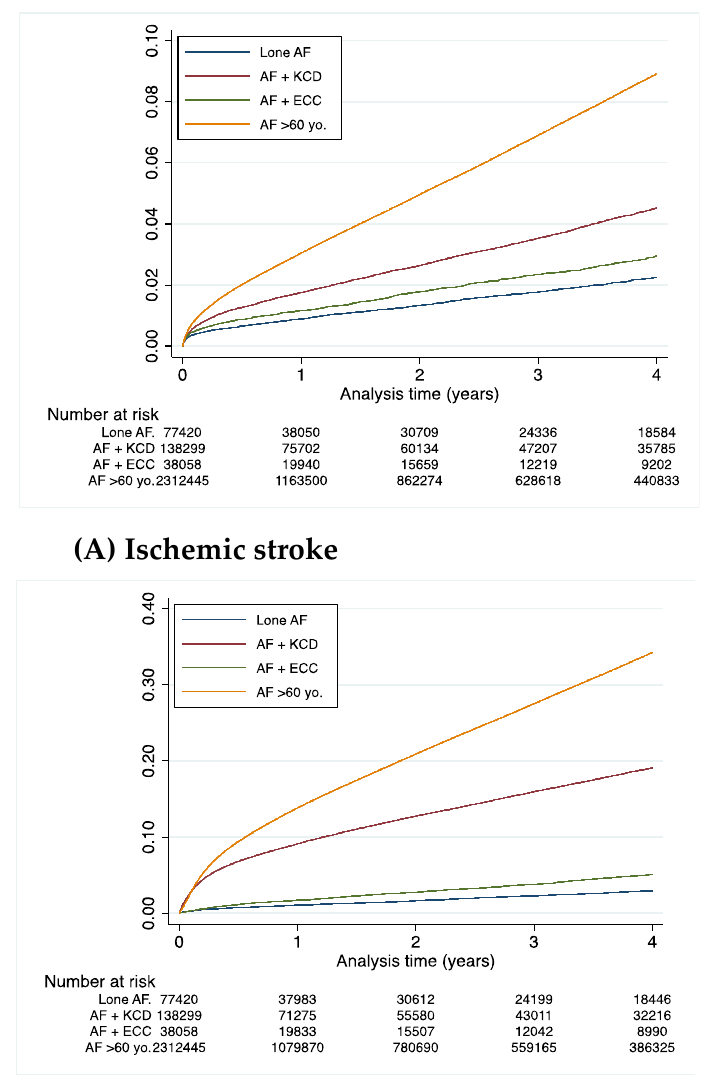
Figure 2. Cumulative incidences of all-cause death ( A ), cardiovascular death ( B ), or non- cardiovascular death ( C ) during follow-up in patients with AF (< 60 years old) (KCD: known cardiac disease; ECC: extra-cardiac comorbidities).